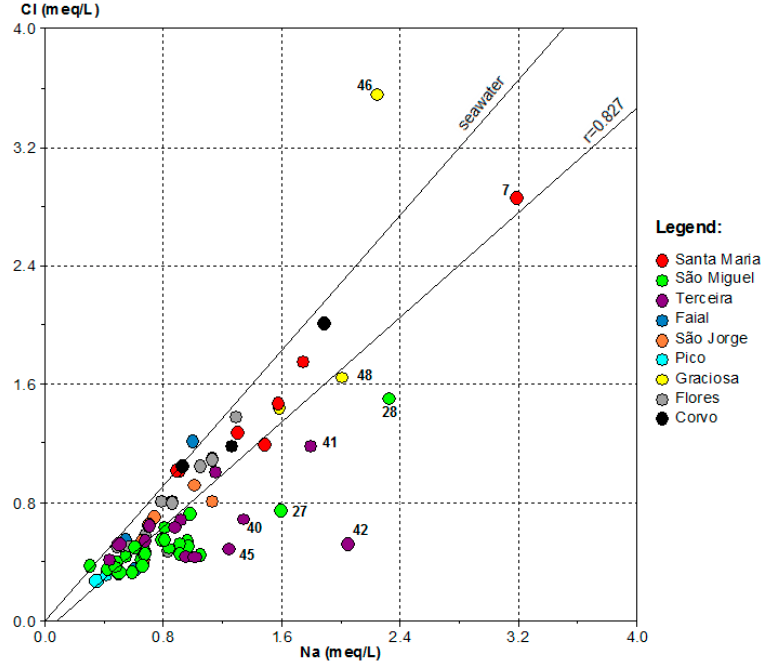
Figure 7. Bivariate plot between Na and Cl content in spring waters (values in meq/L).